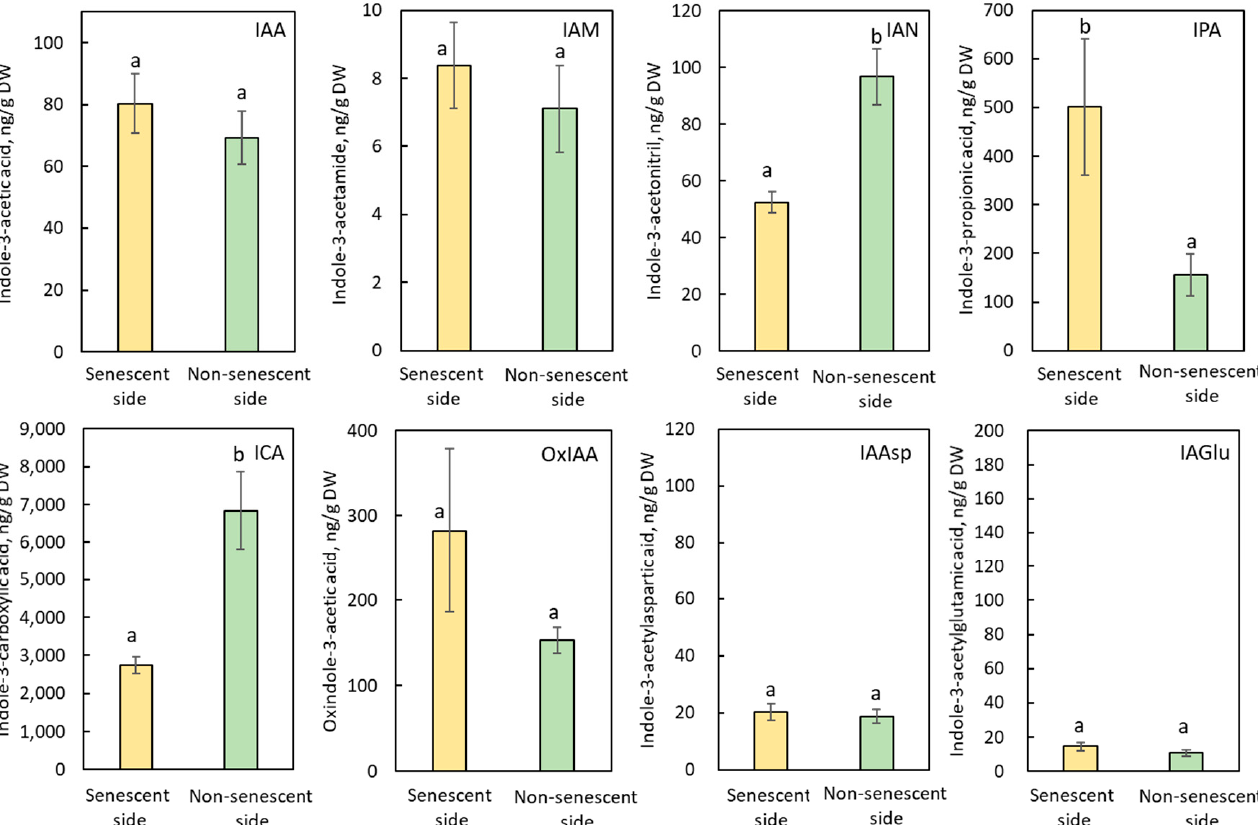
Figure 2. Endogenous levels of auxin-related compounds in the senescent and non-senescent sides of the SAZ induced by JA-Me in the internode explants of Bryophylum calycinum . IAA: indole-3-acetic acid; IAM: in-dole-3-acetamide; IAN: indole-3-acetonitrile; IPA: indole-3-propionic acid; ICA: indole-3-carboxylic acid; OxIAA: 2-oxindole-3-acetic acid; IAAsp: indole-3-acetylaspartic acid; IAGlu: indole-3-acetylglutamic acid. Values are the mean with standard error (n = 6). Different letters on the column (a, b) indicated statistically significant at p < 0.05 after ANOVA.